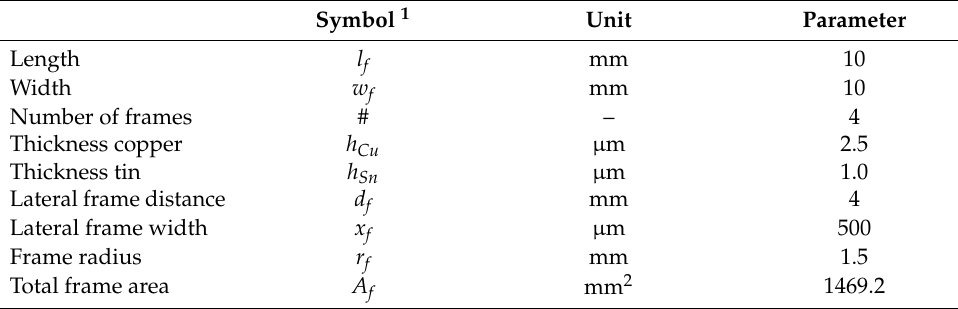
Table 3. Material and design parameters of the bond frames.